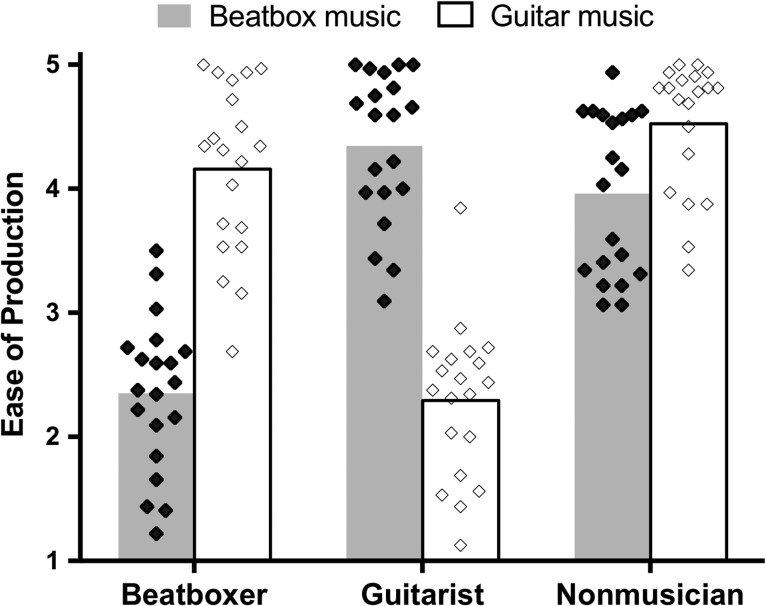
Postscan behavioral ratings provided by each group when listening to clips from the two music conditions (beatbox—gray bars/filled diamonds; guitar—clear/unfilled diamonds). Each data point represents a participant (N = 20 in each group), the bars depict the mean in both conditions. Lower ratings indicate that the stimuli are perceived to be easier to produce.